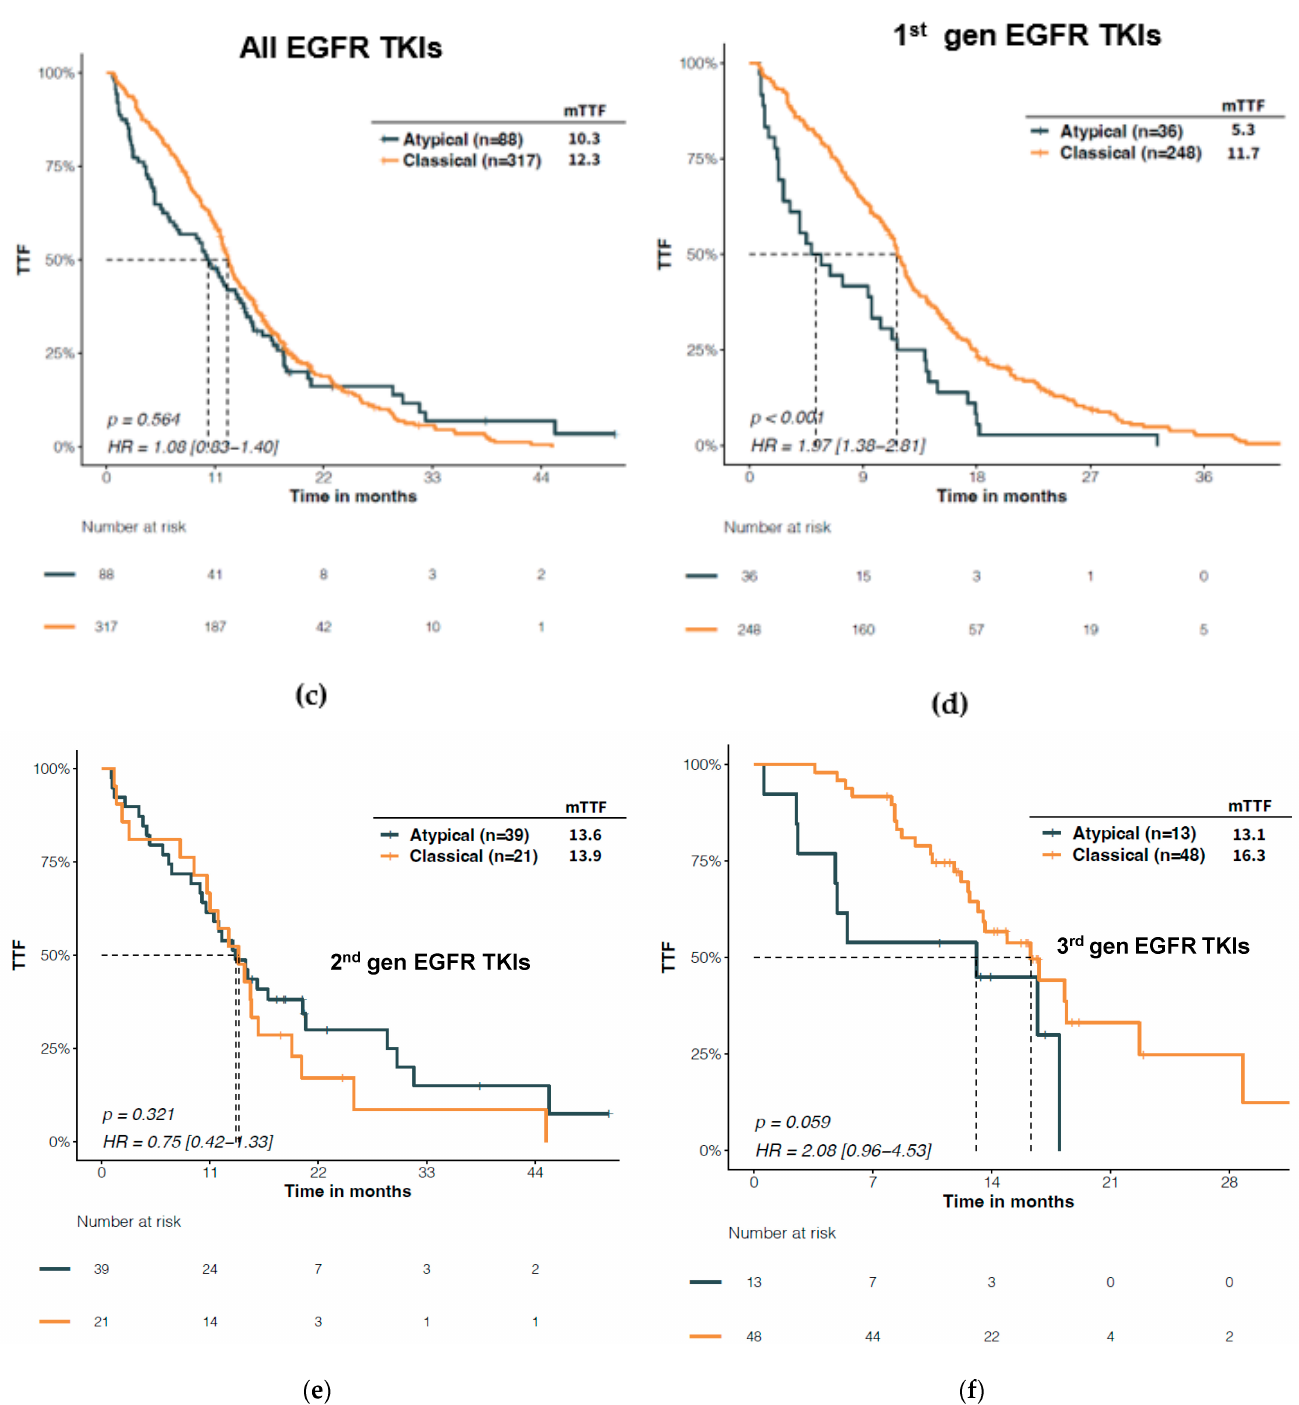
Figure 2. Predictive significance of classical and atypical classification of EGFR mutations for EGFR- TKI efficacy. ( a ) Distribution of classical and atypical classification of EGFR mutations by samples. ( b ) Distribution of atypical EGFR mutations in different exons. Comparison of time to treatment failure (TTF) between patients with classical EGFR mutation and those with atypical mutations upon 1st line treatment with all EGFR TKIs ( c ), 1st gen EGFR TKIs ( d ), 2nd gen EGFR TKIs ( e ), or 3rd gen EGFR TKIs ( f ).